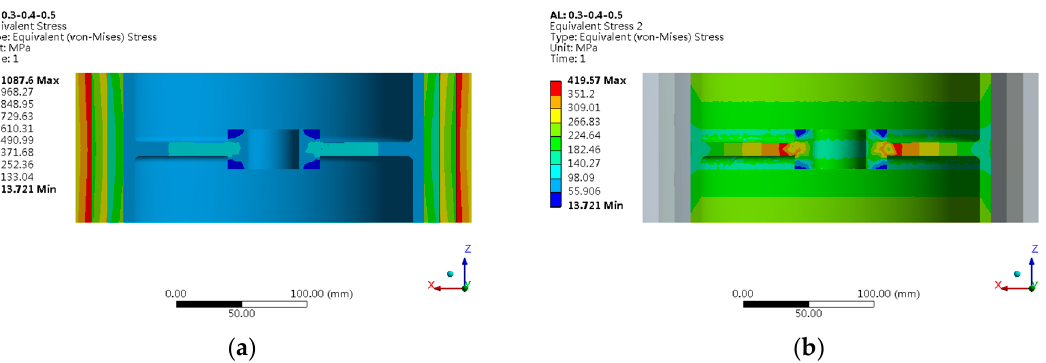
Figure 13. Equivalent stress nephogram of flywheel rotor at maximum speed. ( a ) Overall equivalent stress cloud diagram of flywheel rotor; ( b ) Equivalent stress cloud map of the wheel hub.